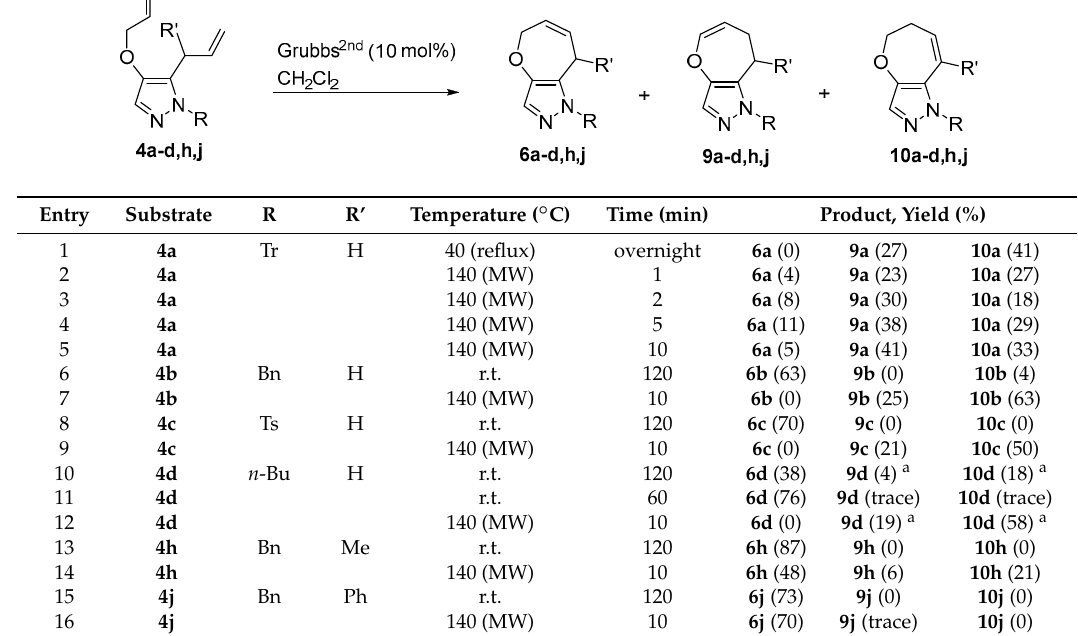
Table 3. RCM of 1-substituted 4-allyloxy-5-allyl-1 H